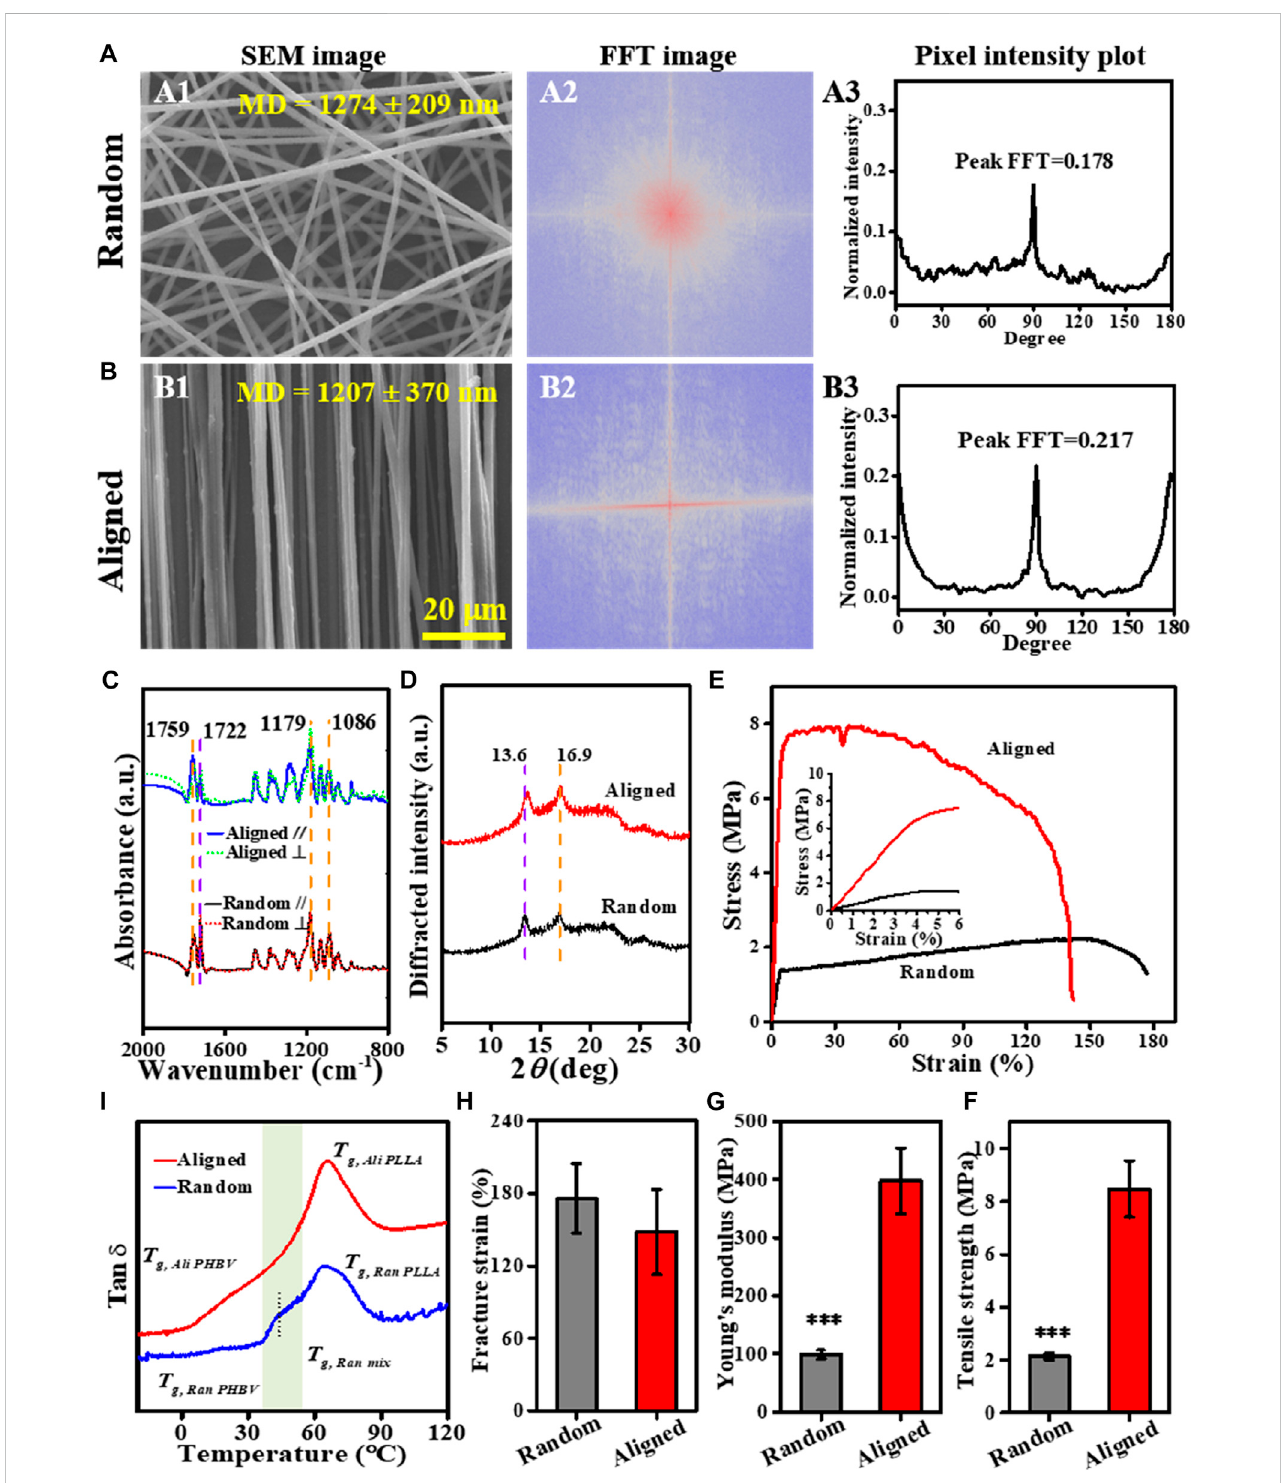
FIGURE 2 Characterization of the PLLA – PHBV based on random and aligned fi brous mats. (A, B) Alignment analysis of the electrospun fi bers: SEM images (A1 and B1), FFT output images (A2 and B2), and pixel intensity plots (A3 and B3). (C) Polarized FTIR spectra [The black and blue lines are obtained with the beam polarized parallel to the fi ber axis (A // ), whereas the dotted red and green lines are obtained with the beam polarized perpendicular to the fi ber axis (A ⊥ )]. (D) XRD patterns. (E – H) Tensile tests showing typical stress – strain curves, tensile strength, Young ’ s modulus, and fracture strain, respectively. (I) Tan δ − temperature curves via